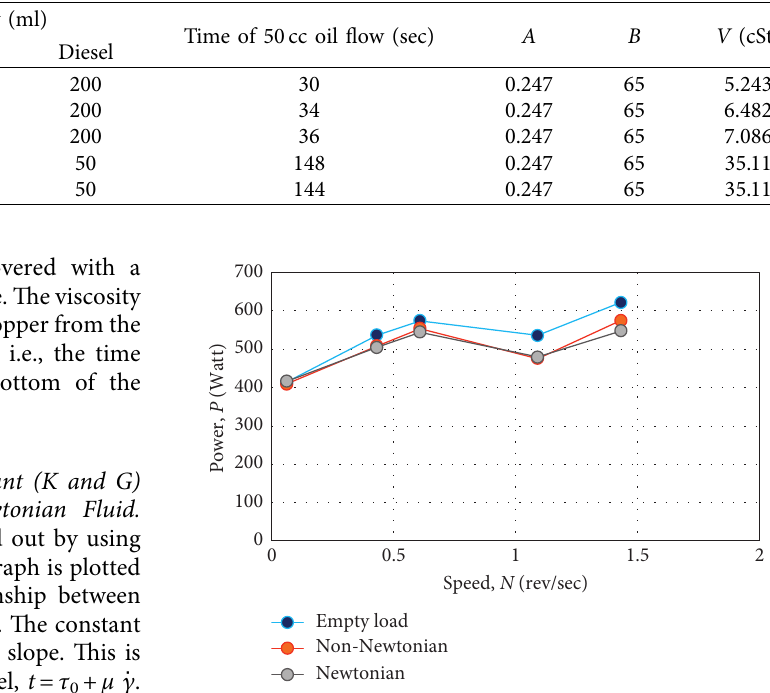
Table 3: Viscosity of heavy gear oil dilution.